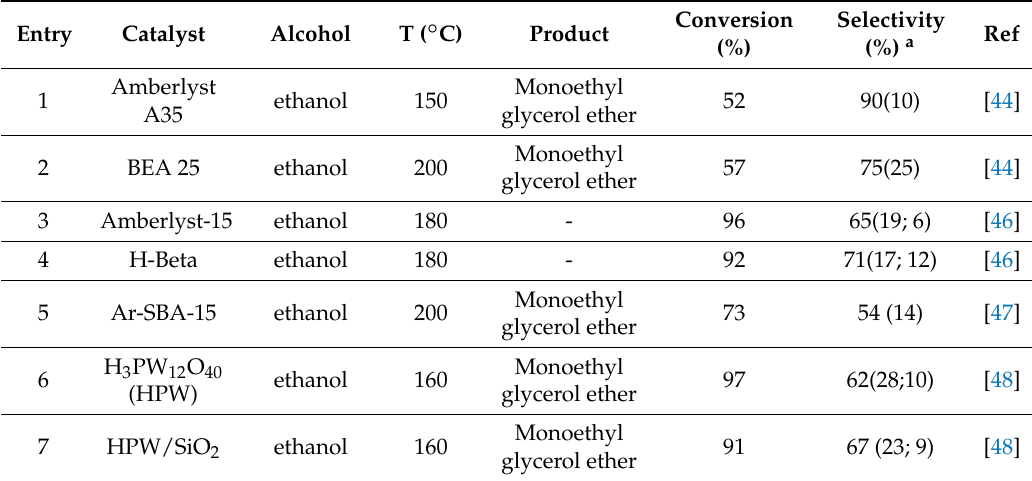
Table 2. Selected examples of the etherification reaction of glycerol and